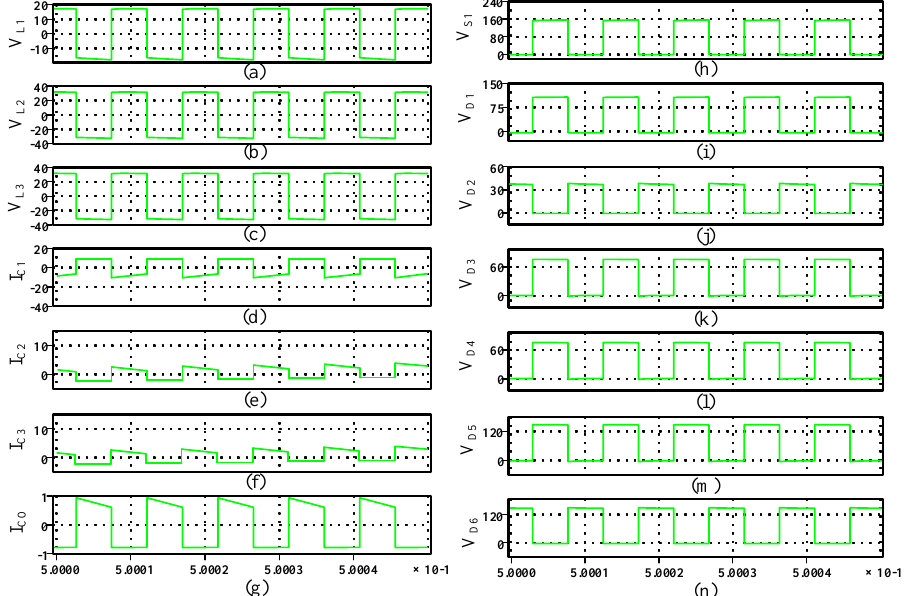
Figure 15. Simulation results: ( a ) first inductor voltage, ( b ) second inductor voltage, ( c ) third inductor voltage, ( d ) first capacitor current, ( e ) second capacitor current, ( f ) third capacitor current, ( g ) output capacitor current, ( h ) switch voltage, ( i ) first diode voltage, ( j ) second diode voltage, ( k ) third diode voltage, ( l ) fourth diode voltage, ( m ) fifth diode voltage, ( n ) sixth diode